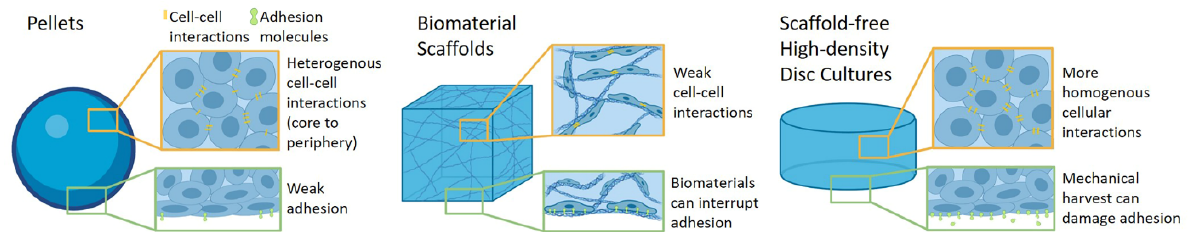
Figure 2. Categories of three-dimensional culture platforms for in vitro mesenchymal stem cell (MSC) differentiation. Cellular interactions (yellow linkers) and surface interface adhesion molecules (green markers) among the constructs varies in response to biomaterials and construct cellular organization. Created with BioRender.com (accessed on 1 March